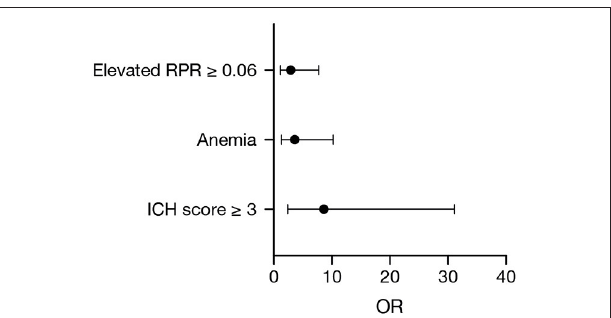
FIGURE 1 | Forest plot of significant and independent predictors of 90-day mortality identified by multivariate logistic regression